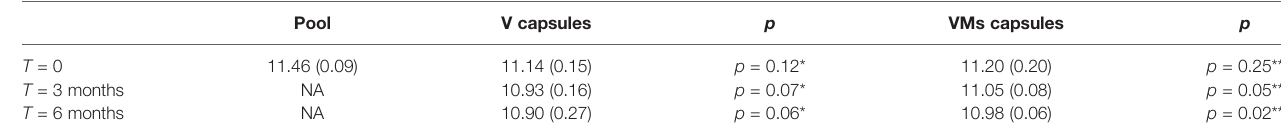
TABLE 2 | Results from fl ow cytometry of Vivapur-101 ® (V) or Vivapur-101 ® +magnesium stearate (VM) adsorbate capsules.